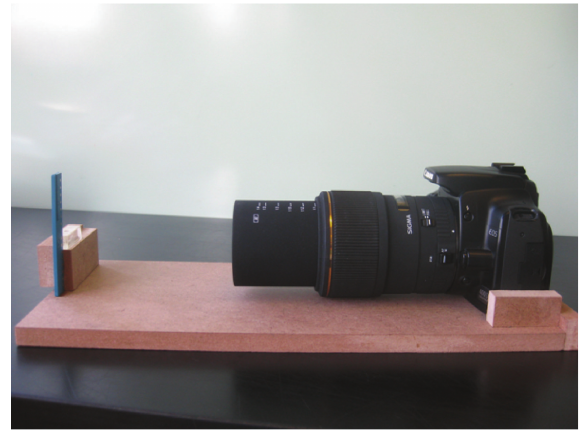
Figure 1: Set-up.